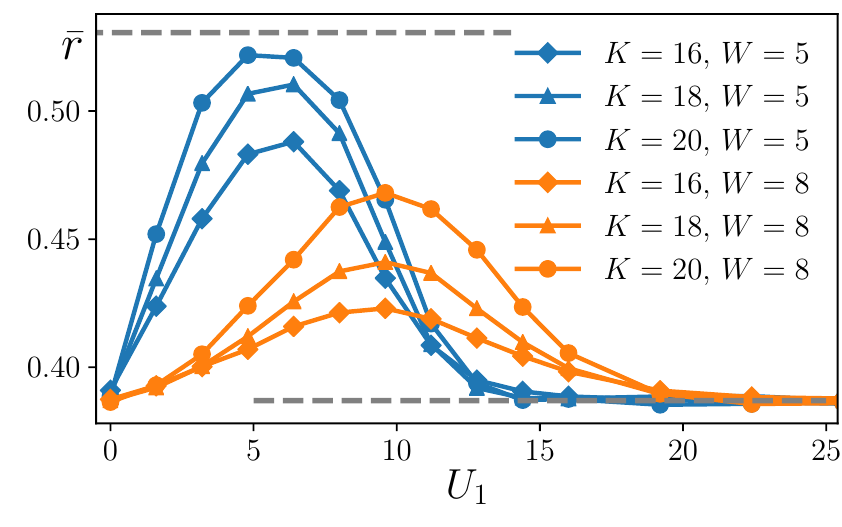
Figure 15: Mean gap ratio r as a function of all-to-all coupling U for different system 1 sizes and fixed disorder strength W . Observe that for a given disorder strength W , the mean gap ratio r first increases, consistently with an appearance of the ergodic phase shown in Fig. 2. Then, for large U , the gap ratio tends back towards the 1 value corresponding to Poisson statistics indicating an occurrence of another non- ergodic phase. The mean gap ratio is determined in the center of the spectrum (for ε = ( E − E ) / ( E − E ) ≈ 0.5). n n min max min